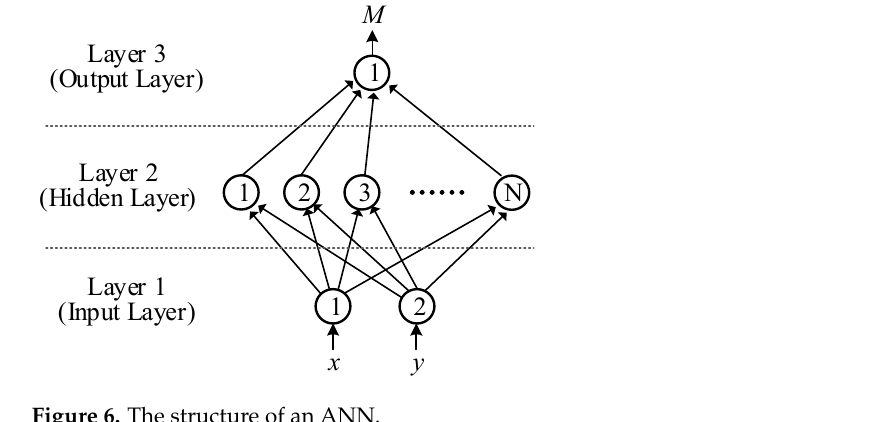
Figure 6. The structure of an ANN.